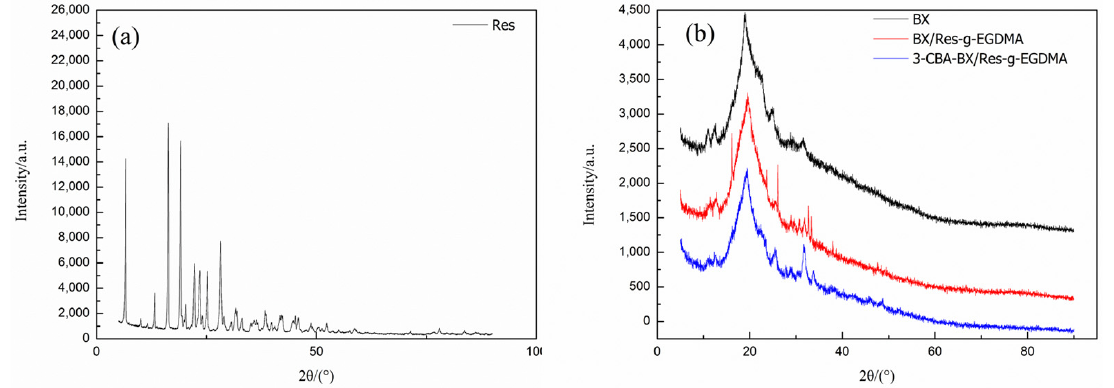
Figure 5. ( a )XRDpatternsofRes. ( b Figure 5. ( a ) XRD patterns of Res. ( b ) XRD patterns of BX, BX/Res-g-EGDMA and 3-CBA-BX/Res-g-EGDMA.